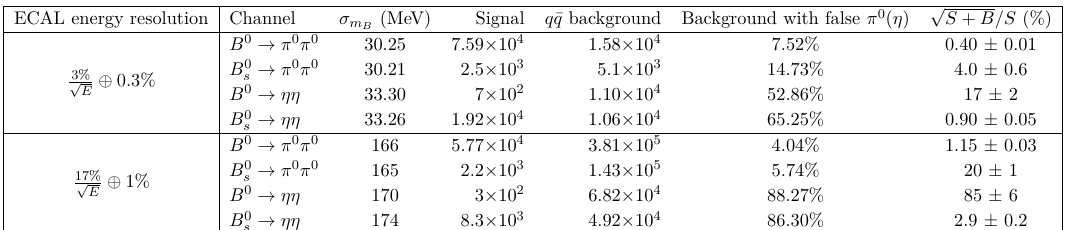
Table 11 . Measurement precisions of B 0 resolutions when using the baseline b